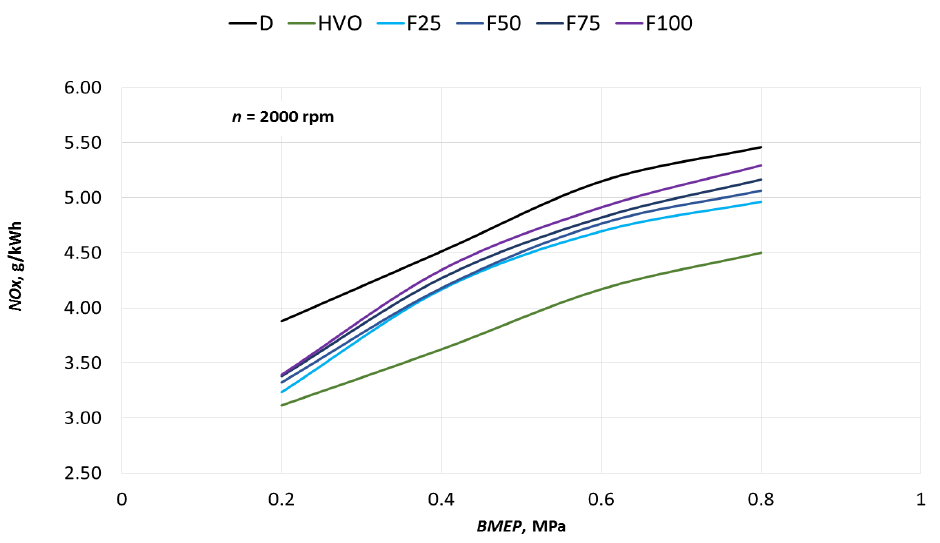
Figure 11. Dependence of nitrogen oxide emissions on the load using different fuels.